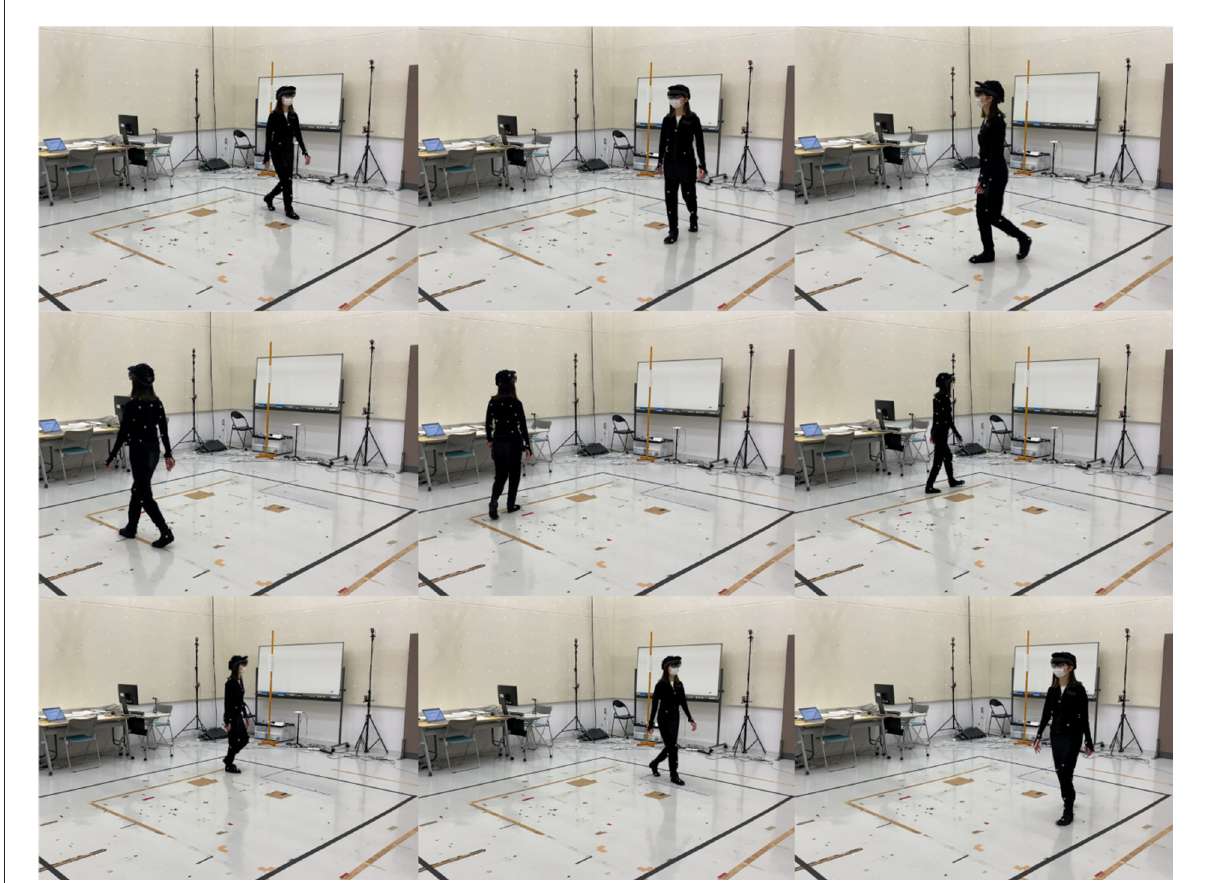
FIGURE6 Sample images of walking subject while watching video on HoloLens